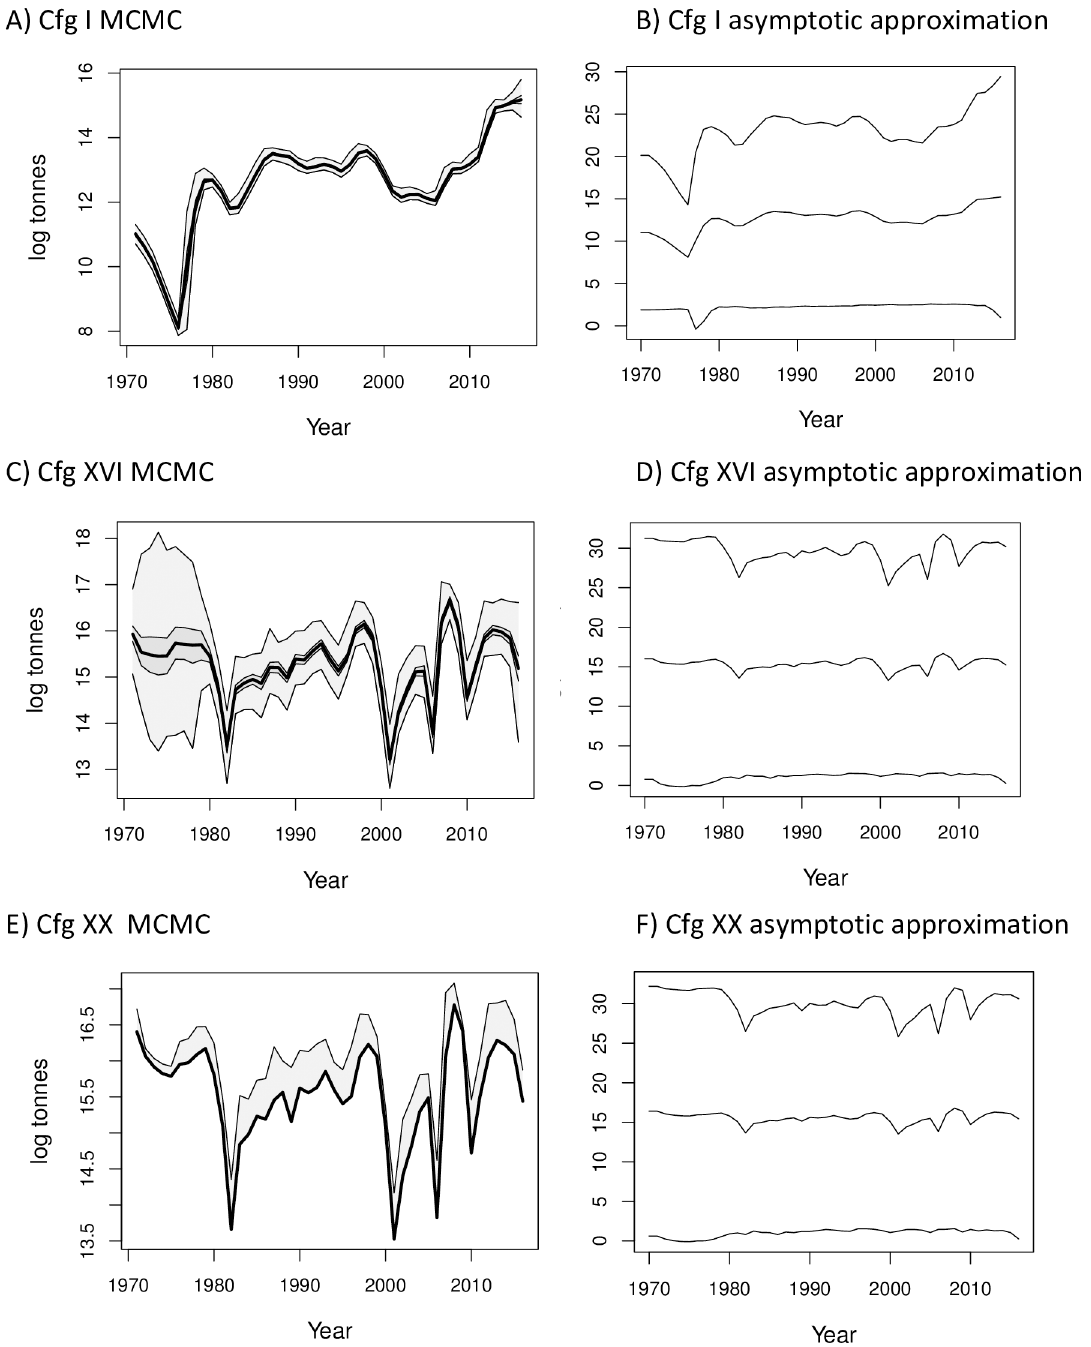
Fig 4. Annual spawning biomass estimates (log tonnes) and associated uncertainty using MCMC and MLE methods applied to cfgs I, XVI, and XX. MCMC quantiles of 0, 0.25, 0.5, 0.75, and 1.0, and 95% CIs around the MLE from the asymptotic approximation are shown. A) Cfg I MCMC, B) Cfg I asymptotic approximation, C) Cfg XVI MCMC, D) Cfg XVI asymptotic approximation, E) Cfg XX MCMC, F) Cfg XX asymptotic